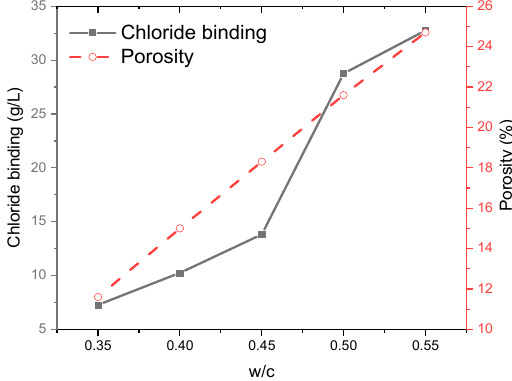
Figure 12. Chloride binding of different w/c mixtures.